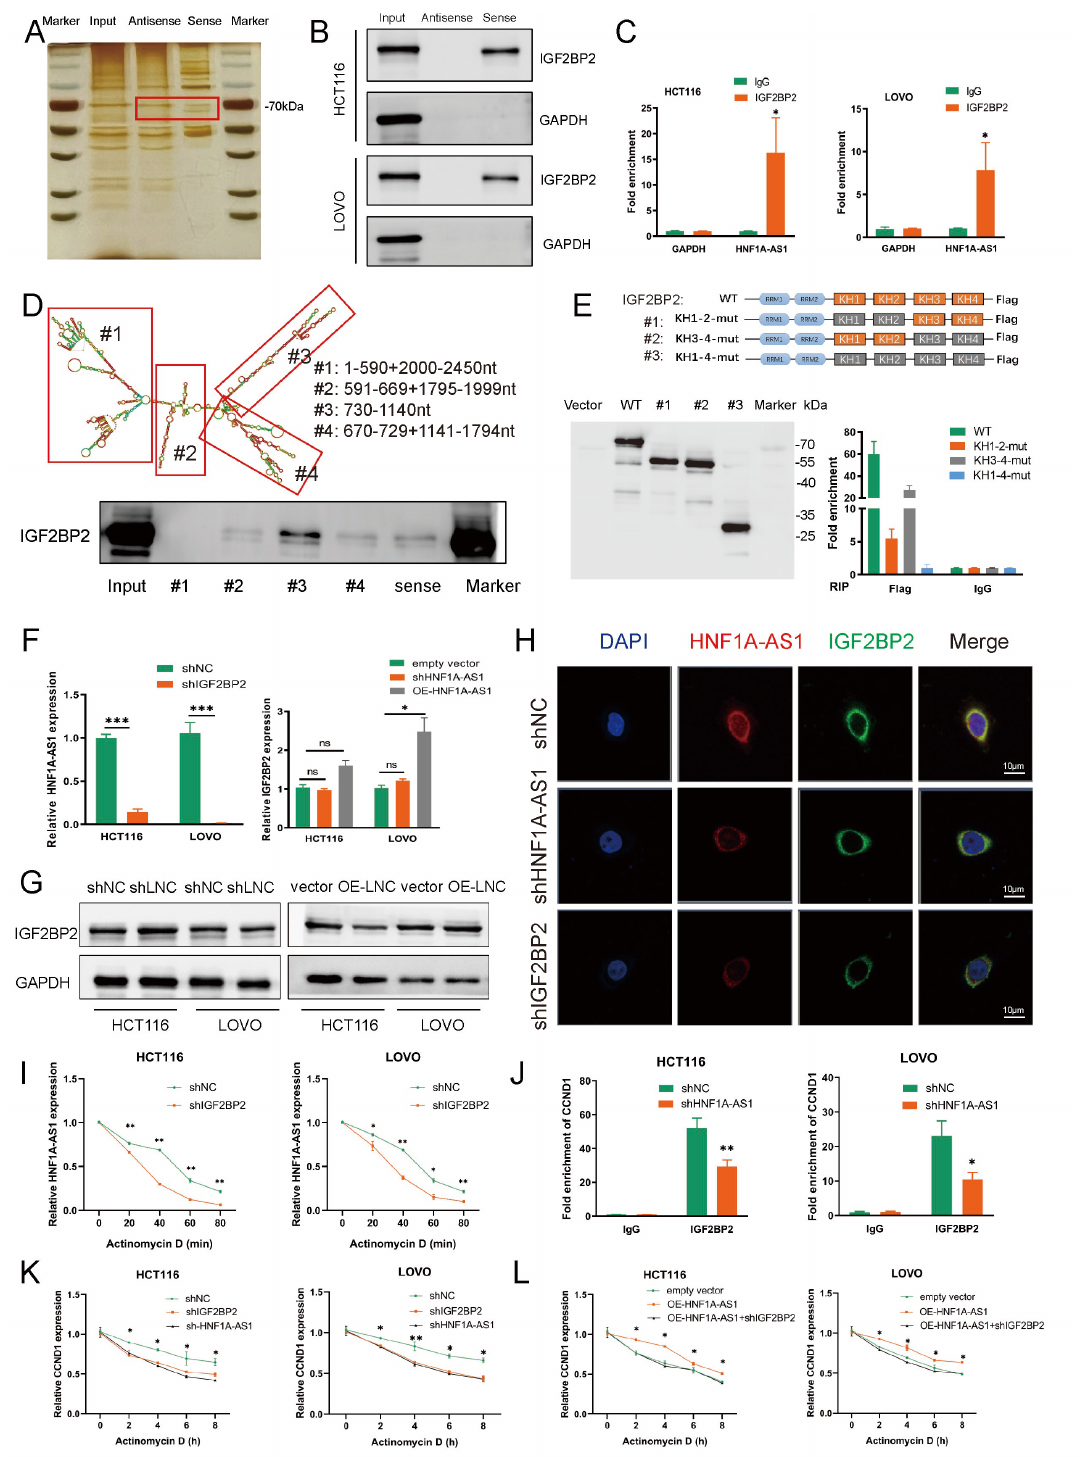
Figure 5. HNF1A-AS1/IGF2BP2/CCND1 complex stabilized CCND1 mRNA. ( A ) RNA pull-down assays were carried out using HNF1A-AS1 sense and antisense plasmids incubated with total protein extracts from CRC cells, followed by silver staining. The red box indicates differently expressed proteins. ( B ) Western blot to confirm the specific interaction between IGF2BP2 and biotinylated HNF1A-AS1, with GAPDH serving as negative control. ( C ) RIP was performed to examine the enrichment between HNF1A-AS1 and IGF2BP2 in HCT116 and LOVO cells. GAPDH served as the negative control. ( D ) Secondary structure of HNF1A-AS1 was predicted from RNAfold website. Several deletions of HNF1A-AS1 were designed to explore the core regions of HNF1A-AS1